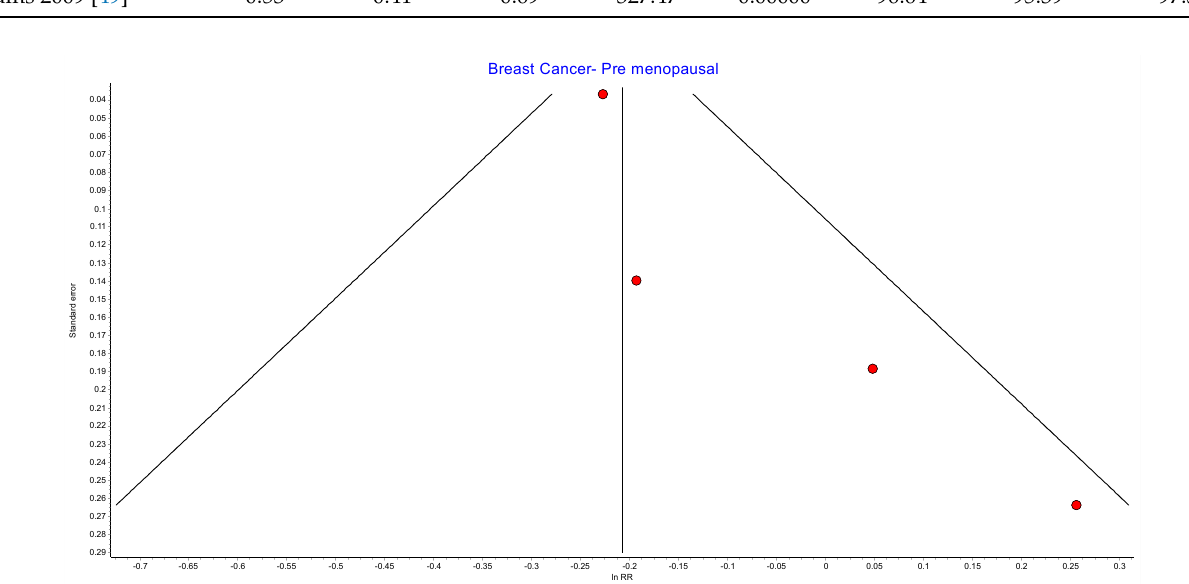
Figure A5. Premenopausal breast cancer random effects model funnel plot. Table A5. Premenopausal breast cancer random effects model sensitivity analysis.